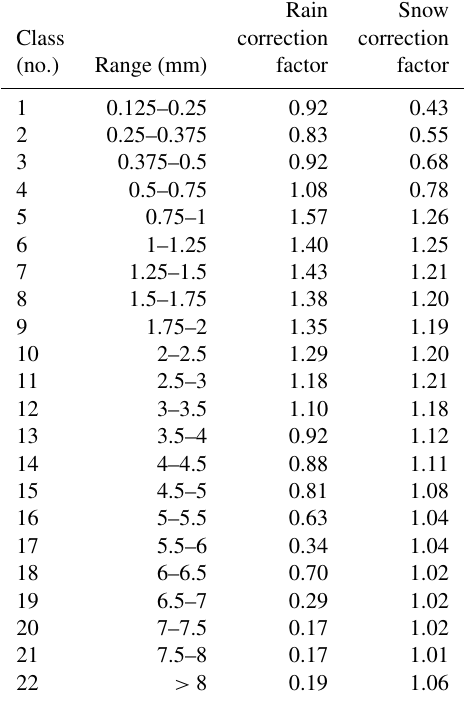
Table 3. Correction factors for the number of particles in 22 diam- eter classes as measured by the Thies disdrometer, resulting from a comparison to the two-dimensional video disdrometer in the cal- ibration period. Measurements are separated into rain and snow based on the recorded dominant precipitation type by the Thies dis- drometer